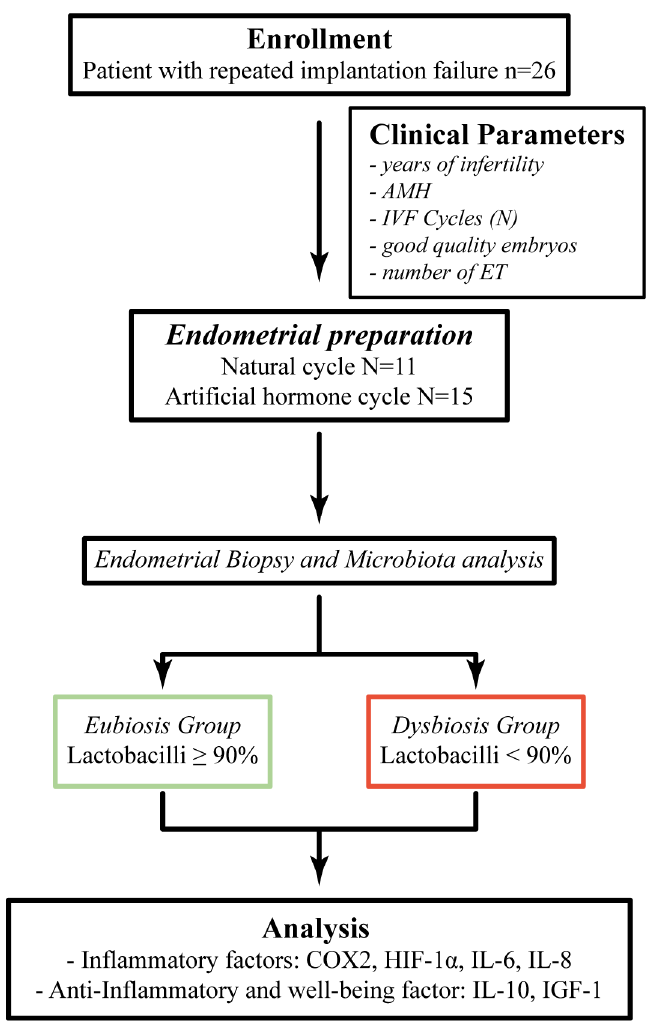
Figure 1. Schematic overview of the clinical workflow. Good quality embryos, number of IVF cycles, number of embryo-transfer (ET) and good quality embryos/number of trials are expressed as median values. AMH: anti-Mullerian hormone.